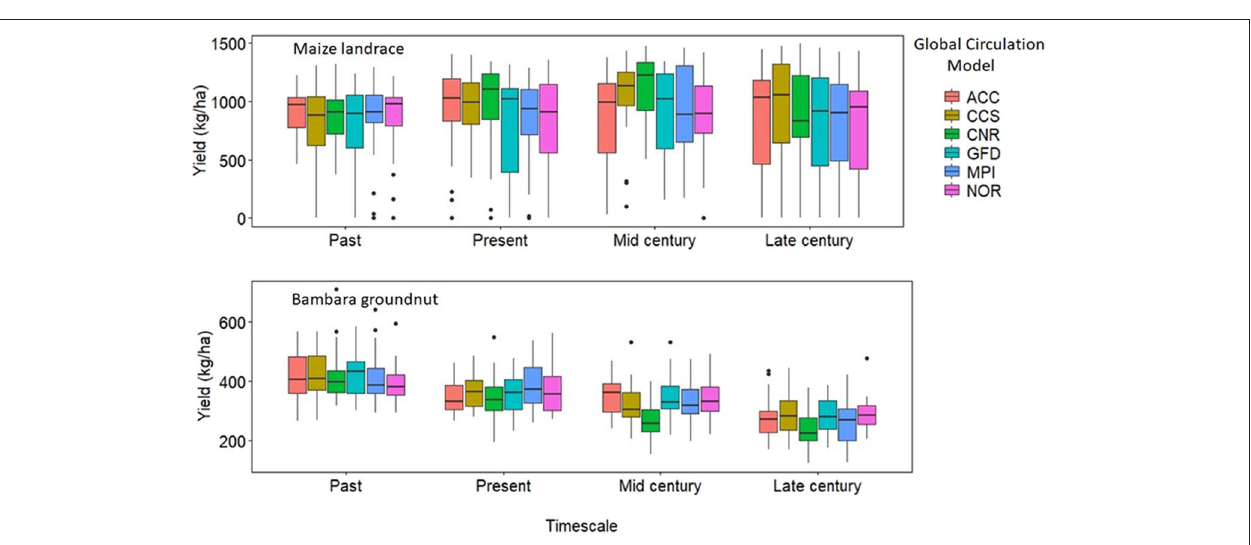
timescales. Overall, CCS predicted the highest water use (265 and 253 mm), while the lowest was under NOR (242 and 235 mm) for maize landrace and bambara groundnut, respectively ( Figure 5